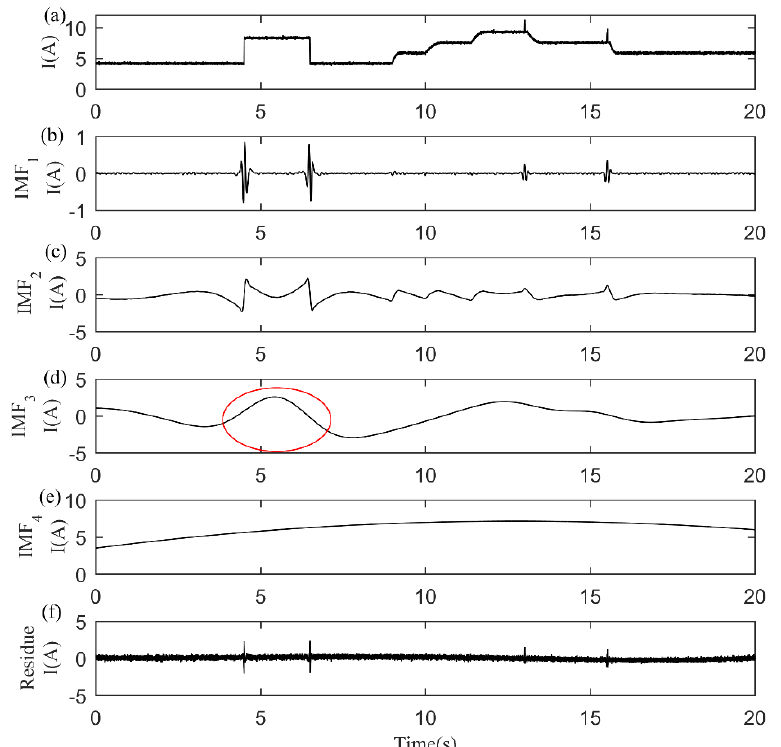
Figure 22. EEMD decomposition diagram of the experimental signal. ( a ) Experimental current signal; ( b ) IMF 1 component; ( c ) IMF 2 component; ( d ) IMF 3 component; ( e ) IMF 4 component; ( f ) Residue.